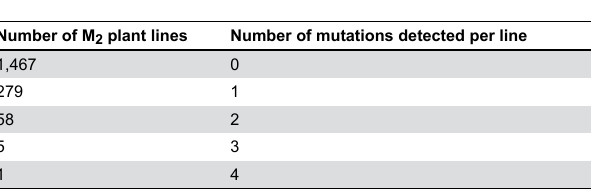
Table 3. Number of mutations per plant in regions screened.